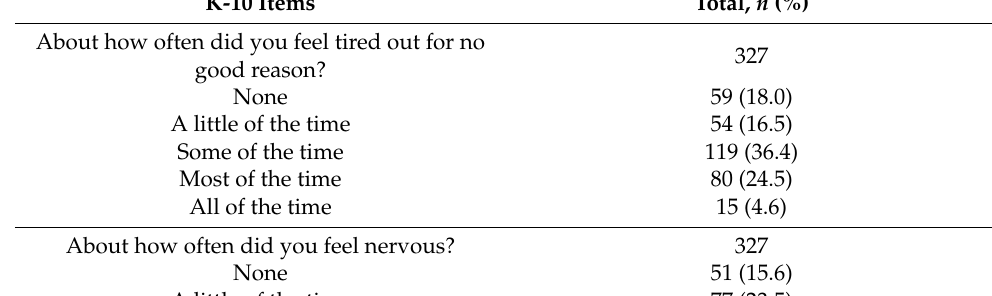
Table 2. Level of psychological distress among the study participants. K-10 Items Total, n